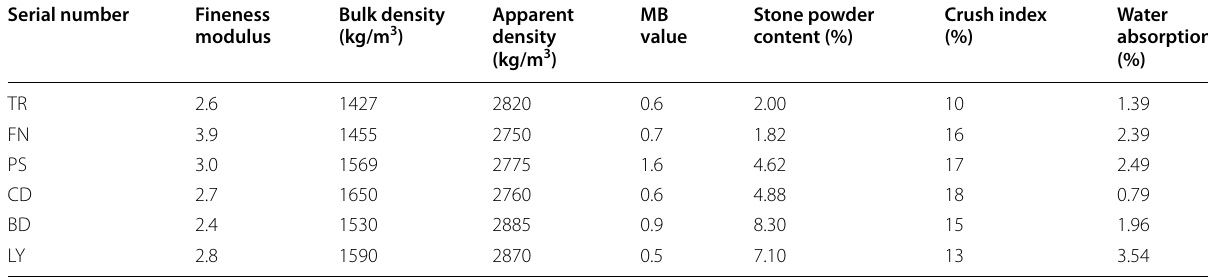
Table 2 Physical properties of fine